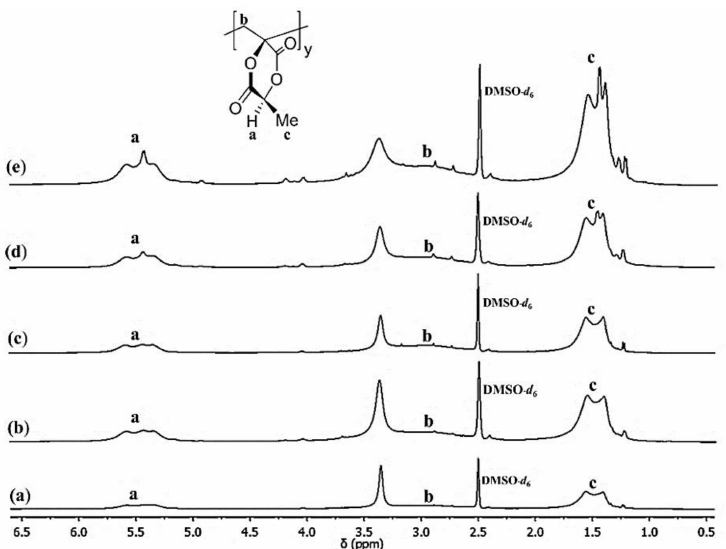
Figure 2. 1 H-NMR (400 MHz, DMSO- d 6 ) spectra of poly(methylenelactide) with different amounts of AIBN (5, 10, 15, 20, 25 mol%): ( a ) PMLA 5 ; ( b ) PMLA 10 ; ( c ) PMLA 15 ; ( d ) PMLA 20 ; and ( e ) PMLA 25